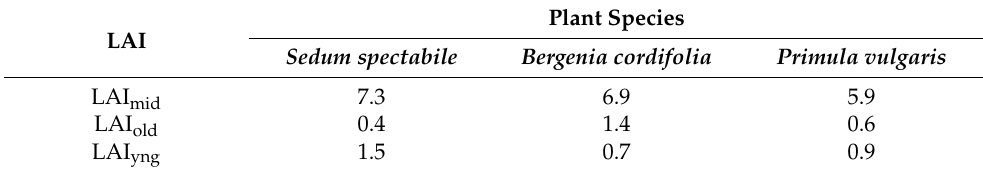
Table 2. Leaf area index values of Sedum spectabile, Bergenia cordfolia and Primula vulgaris. Plant Species LAI Sedum